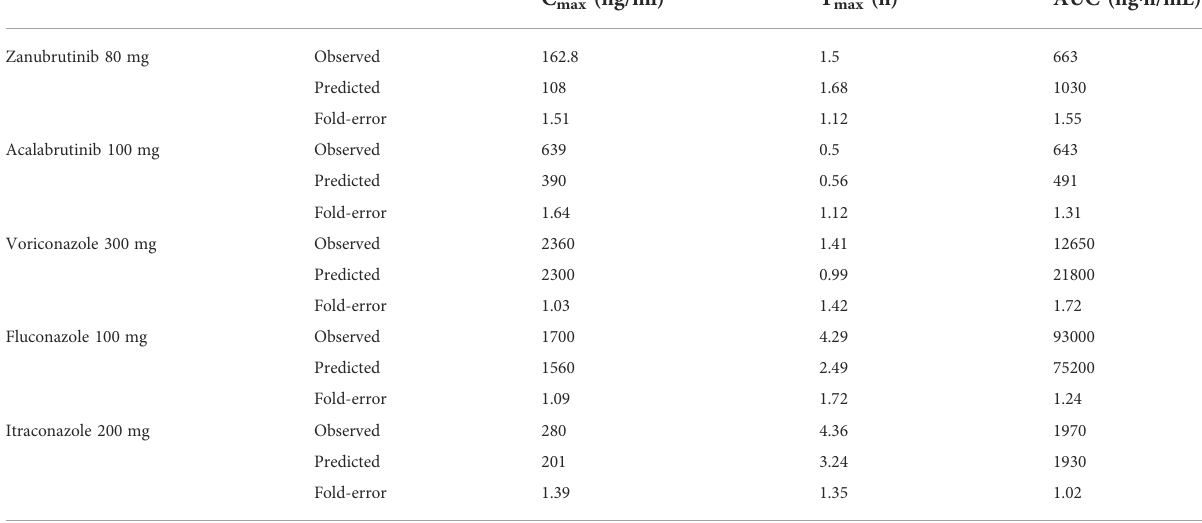
TABLE 2 Observed and predicted PK parameters of zanubrutinib, acalabrutinib, voriconazole, fl uconazole and itraconazole. C max (ng/ml) T max (h) AUC (ng ·